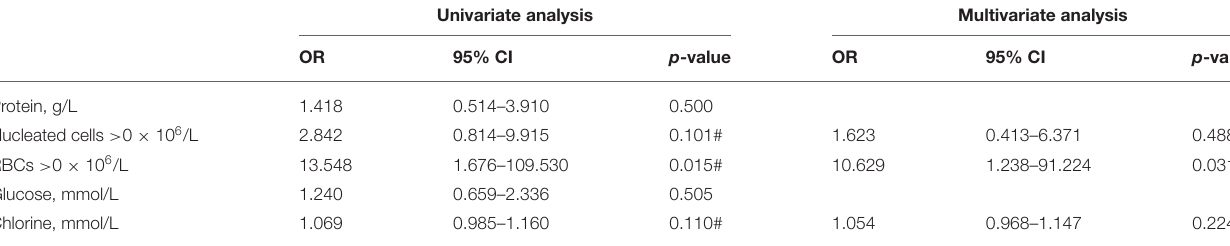
TABLE 3 | Binary logistic regression analysis of the association of CSF parameters with early